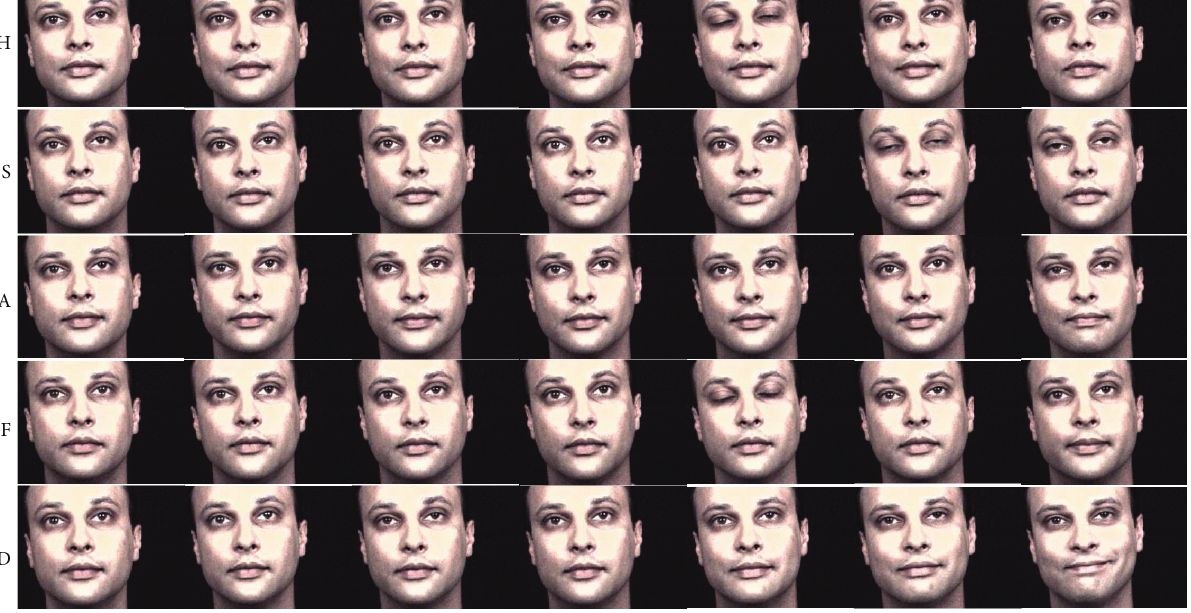
Figure 5: Sample videos of a subject with low ambiguity and low distinctiveness . Facial expressions of low ambiguity and low distinctiveness present themselves as muted or flat expressions throughout all